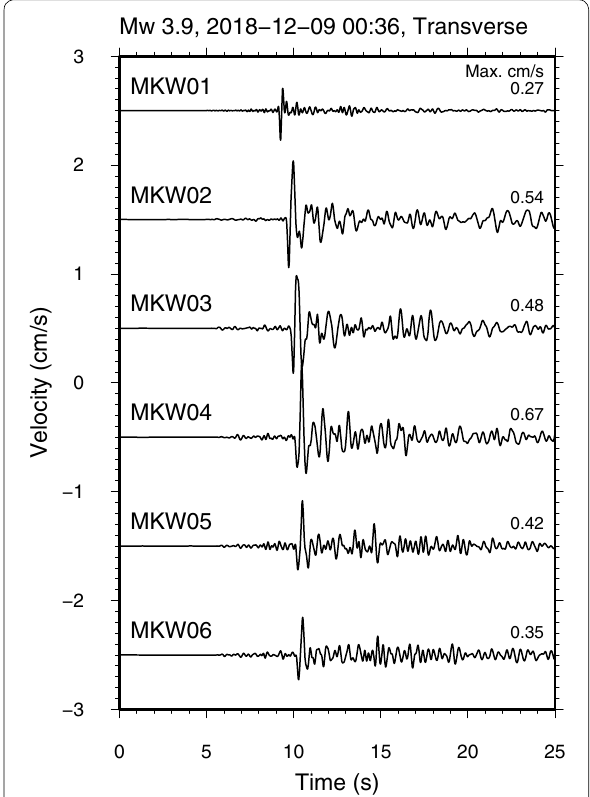
Fig. 14 Transverse component velocity waveforms for the M w 3.9 earthquake (Event 2: 09 December 2018). These velocity waveforms were derived from the acceleration records of a temporary line array observation (MKW01-06) in Mukawa town with a 0.05–5 Hz bandpass filter. The line array is shown in Fig. 5 and the epicenter of Event 2 is shown in Fig.